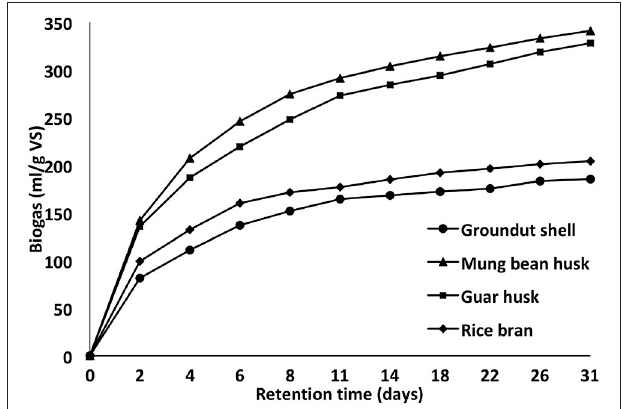
FIGURE 4 | Accumulated biogas production from agro-industrial